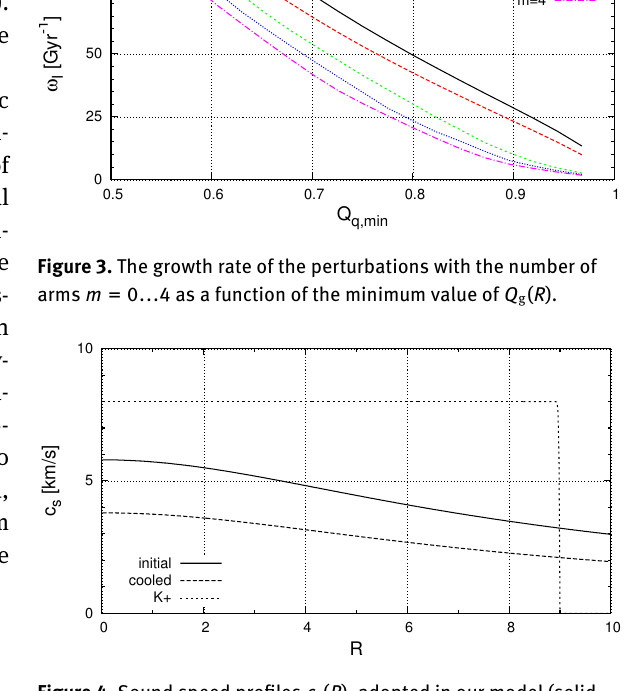
Figure 4. Sound speed profiles c s ( R ), adopted in our model (solid line), in K+ at the initial moment (short dashed line) and corre- sponding to the cooled model with Q ≈ 0.79 (dashed line). g,min